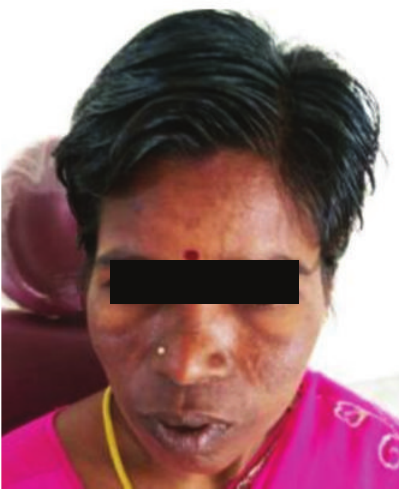
Figure 1: Swelling in the left maxillary region.